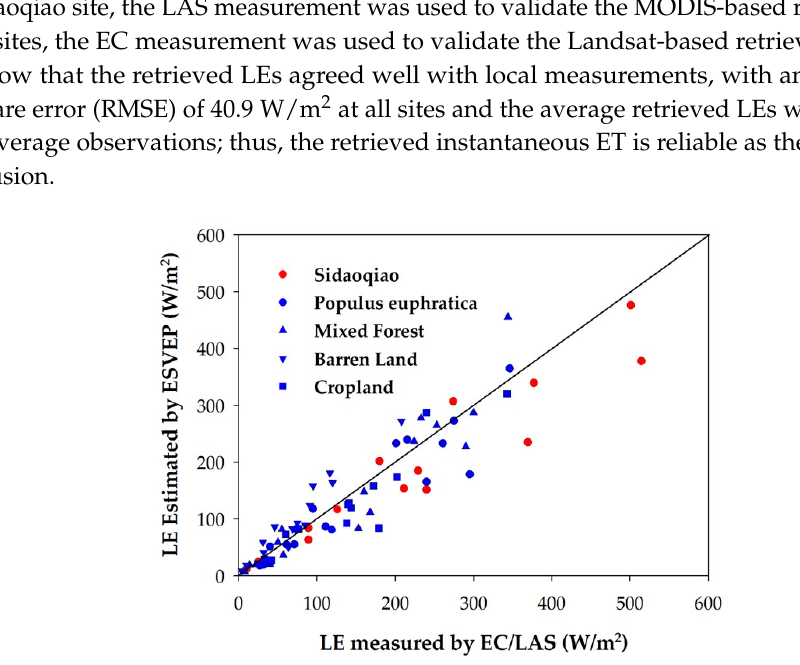
Figure 3. Validation of the instantaneous LE estimations from the end-member-based soil and vegetation energy partitioning (ESVEP) model for MODIS- and Landsat-based retrievals against ground-based LAS (red symbols) and EC (blue symbols)